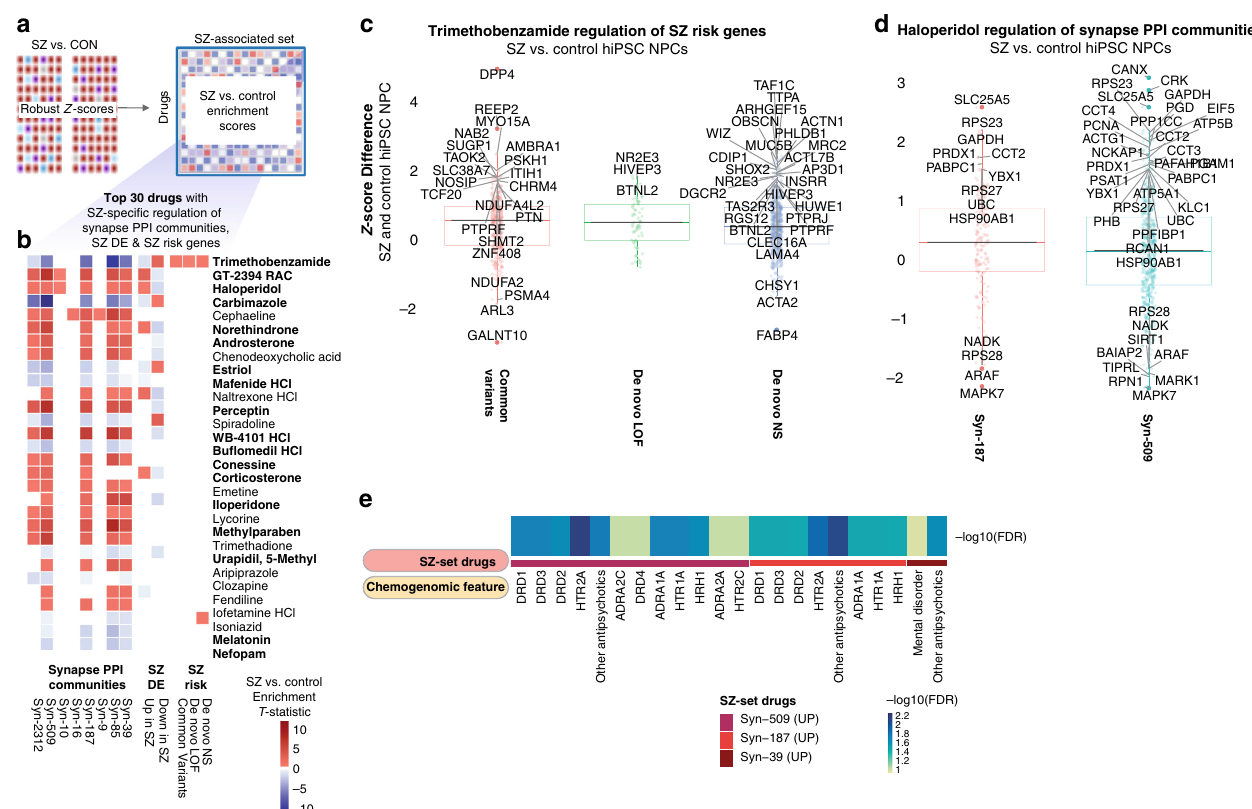
Fig. 5 Drug-induced regulation of SZ biology varies between hiPSC NPCs derived from SZ patients compared with healthy controls. a A gene-set enrichment approach was applied to identify drugs that regulated expression of SZ-set genes differently in pro fi les generated on SZ and control hiPSC NPCs. b Top 30 drugs with highest collective cell-line type-speci fi c perturbation of synaptic protein interaction clique (PPI) communities, genes differentially expressed in prefrontal cortex of individuals with SZ (SZ DE), and genes harboring common and de novo SZ-risk-associated variants. Squares with enrichment FDR > 0.1 are shown as white. Highlighted in bold are the 18/30 drugs that were independently identi fi ed as drugs that normalized SZ- related transcriptional signatures in Fig. 3c. c Trimethobenzamide shows strong SZ/control differential regulation of SZ-risk genes (Z-score difference > 1.5 labeled as solid fi lled circles with dark red, green or blue color). d Haloperidol shows strong SZ/control differential regulation of synaptic PPI communities (representative synaptic PPI communities, Z-score difference > 1.5 labeled as solid fi lled circles with dark red or blue color). e Strong enrichment observed for drugs that differentially regulated speci fi c synaptic PPI communities (SZ-set drugs), particularly by antipsychotic drugs that targeted dopaminergic and serotoninergic neurotransmitter receptors (chemogenomic